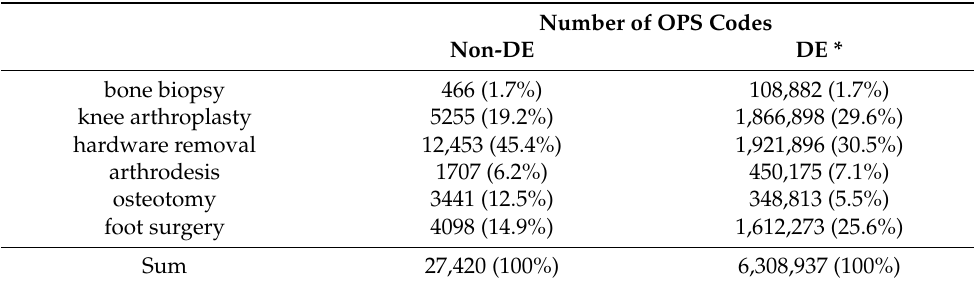
Table 1. Number of OPS codes for both groups between 2010 and 2020.